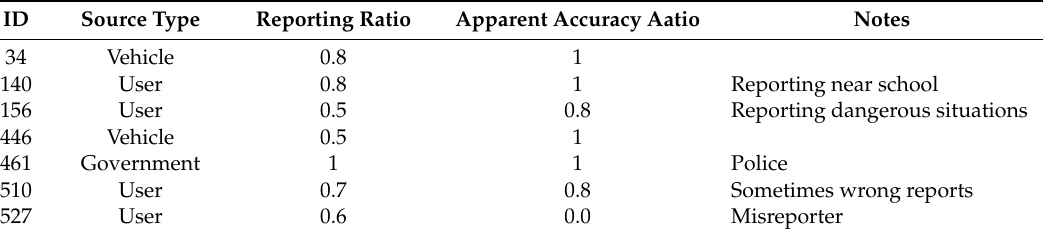
Table 1. Excerpt from the sources / personas